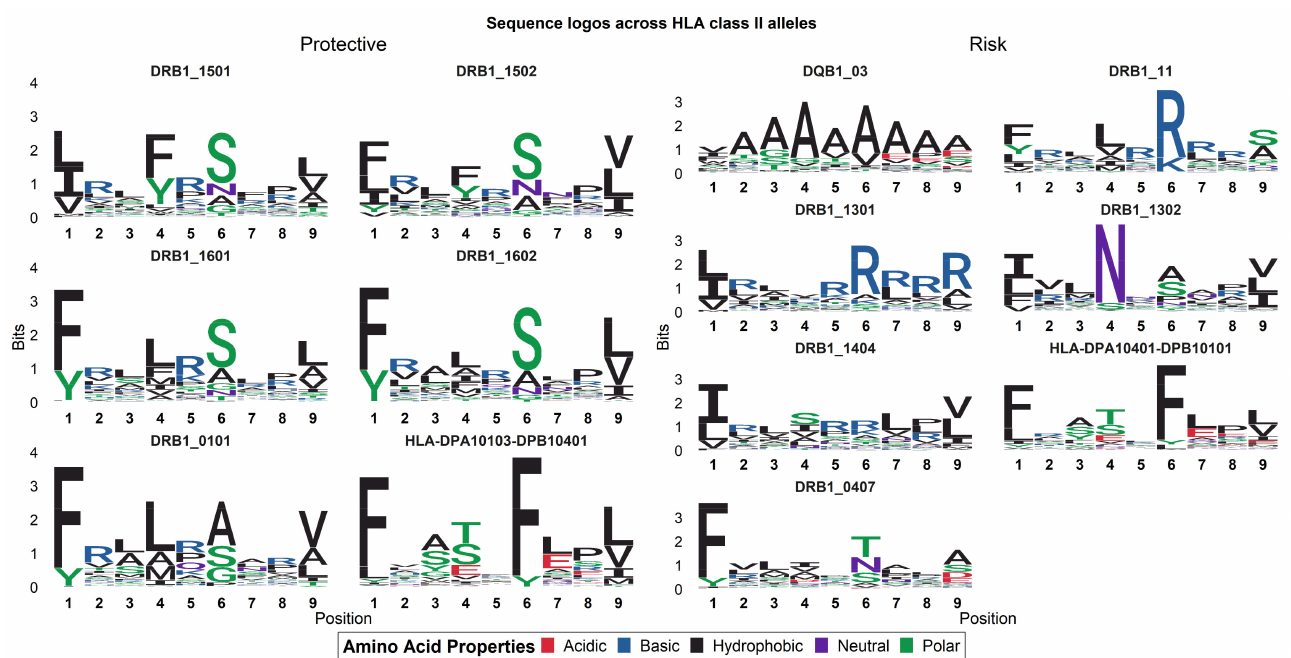
Figure 2. Consensus sequence logos of the 9 mer binding cores of predicted epitopes across HLA class II alleles. This plot shows the sequence conservation level (in bits) of an amino acid occurring at a certain position in the binding core. Protection and risk-associated HLA alleles have been separated in a 2-column